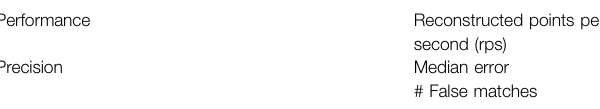
TABLE 2 | The quantitative criteria of performance and precision de fi ning our evaluation metrics and their sub